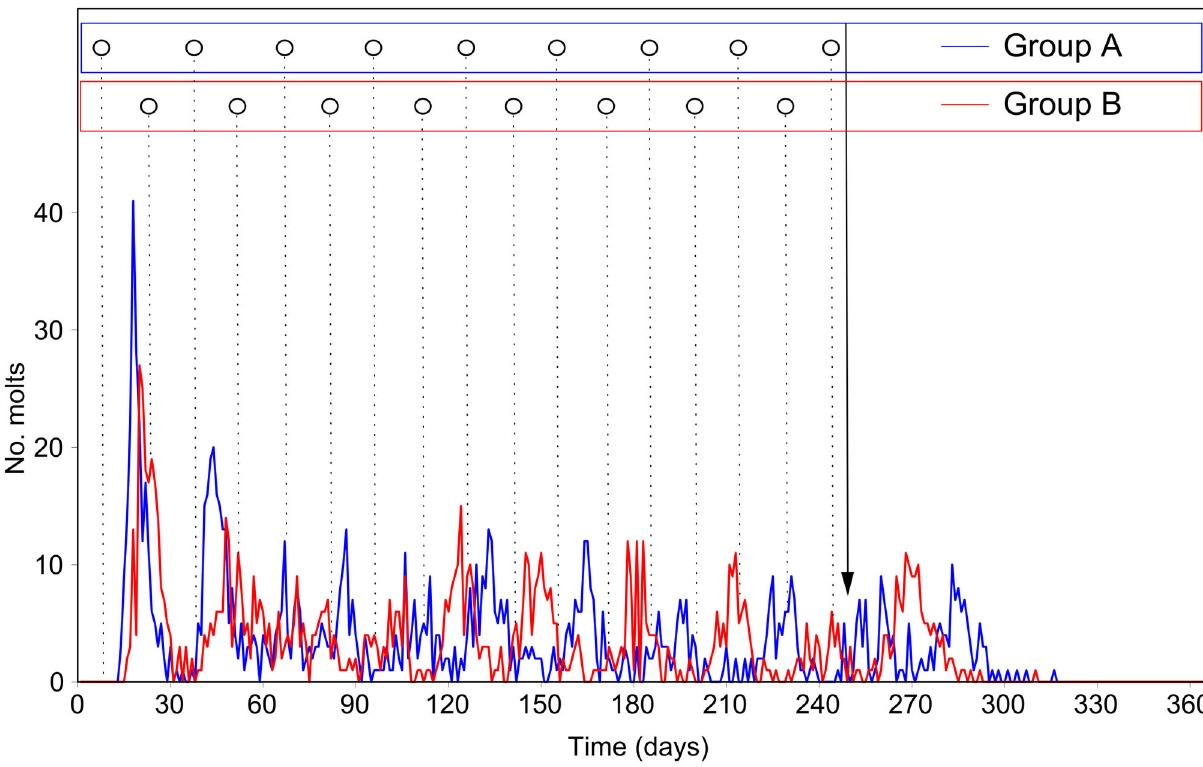
Figure 6. Daily molt frequencies over a one year period under artificial moonlight cycles (experiment 2). Open circles indicate full moons; day 1 = March 30, 2012; day 365 = March 29, 2013. Group A (blue): artificial cycle in phase with the natural lunar cycle; Group B (red): artificial cycle phase-shifted by half the lunar period. Arrow: Termination of moonlight regimes on December 03 (Day 249).